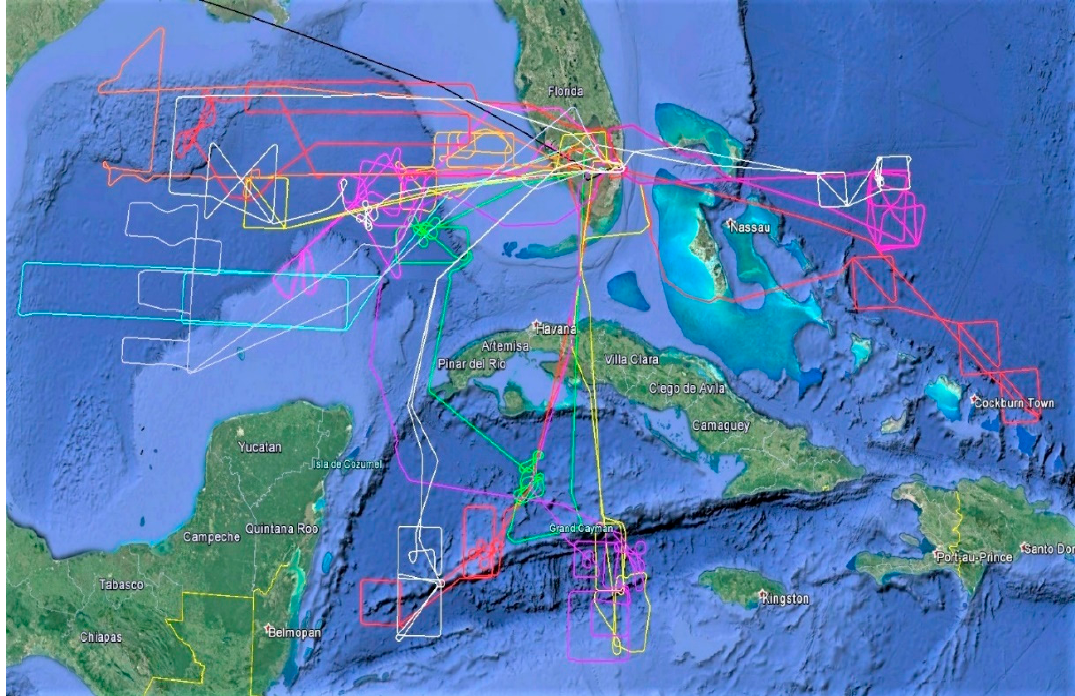
Figure 1. Location of sixteen flight missions during the 2017 CPEX field campaign (Google Earth).